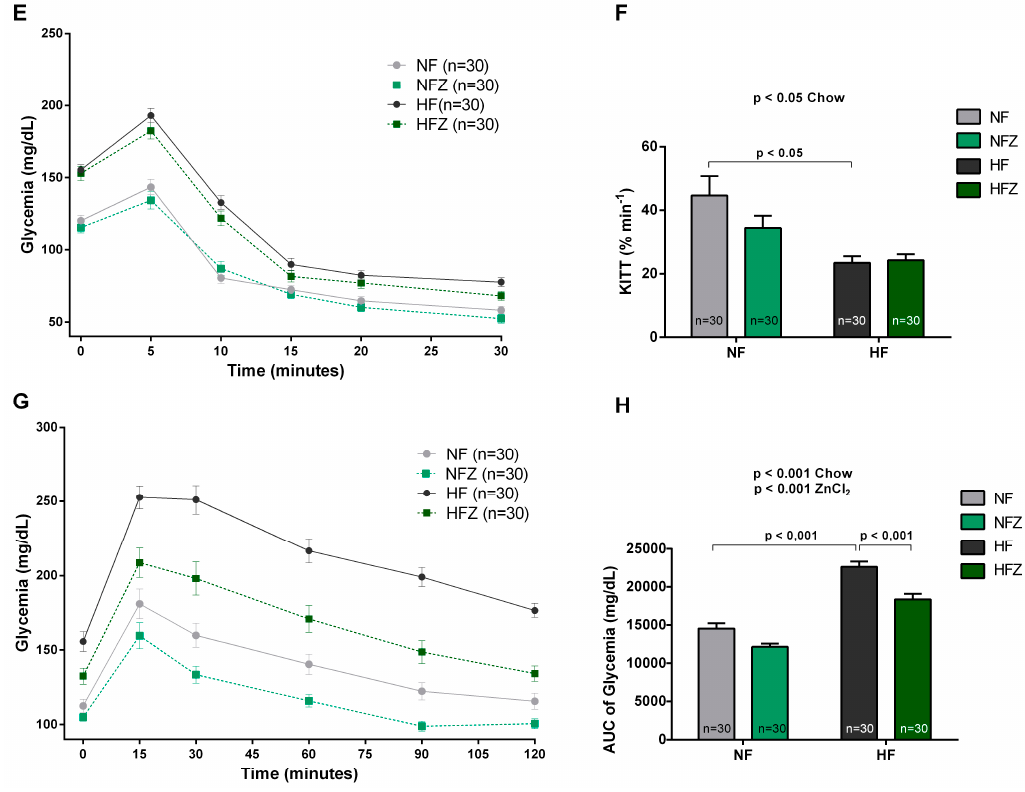
Figure 2. Serum parameters analysis. Glycemia ( A ), insulinemia ( B ), HOMA-IR ( C ), HOMA- β ( D ),